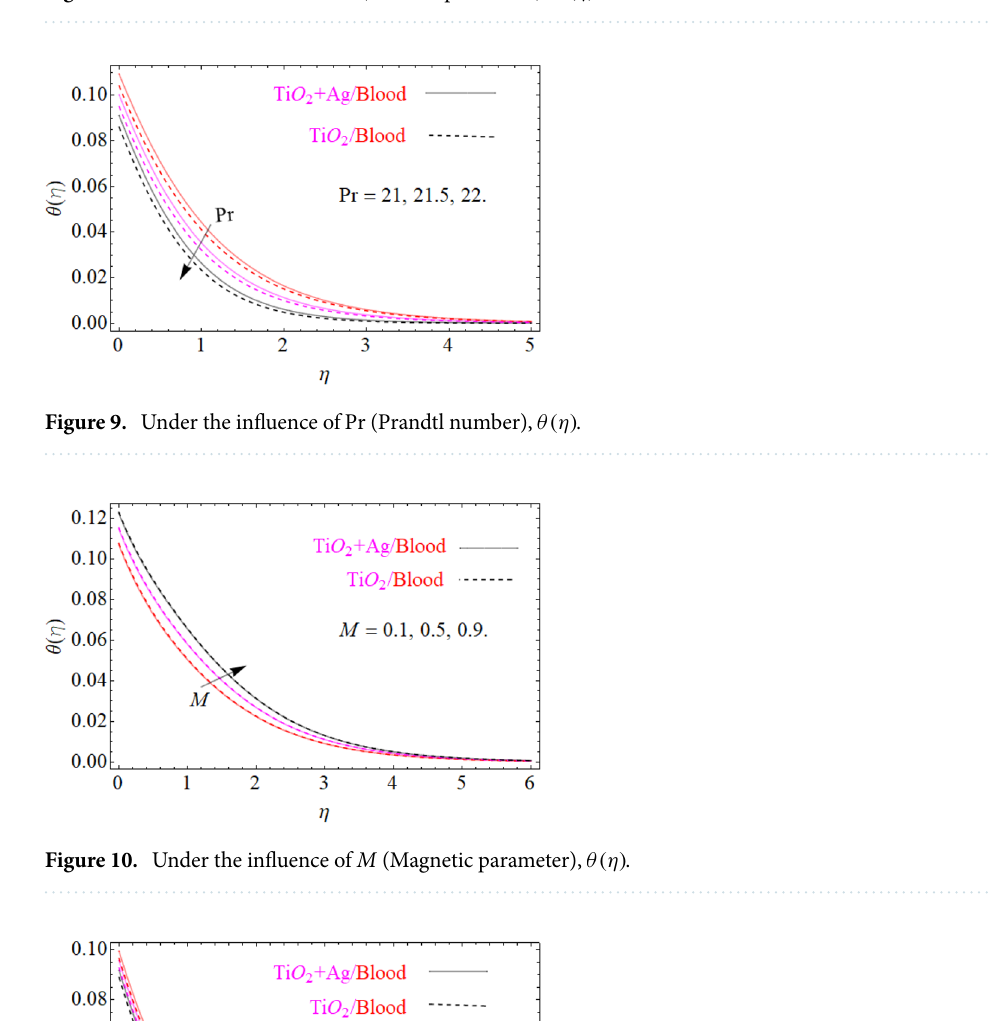
Figure 8. Under the influence of (cid:31) (rotation parameter), G (η) .